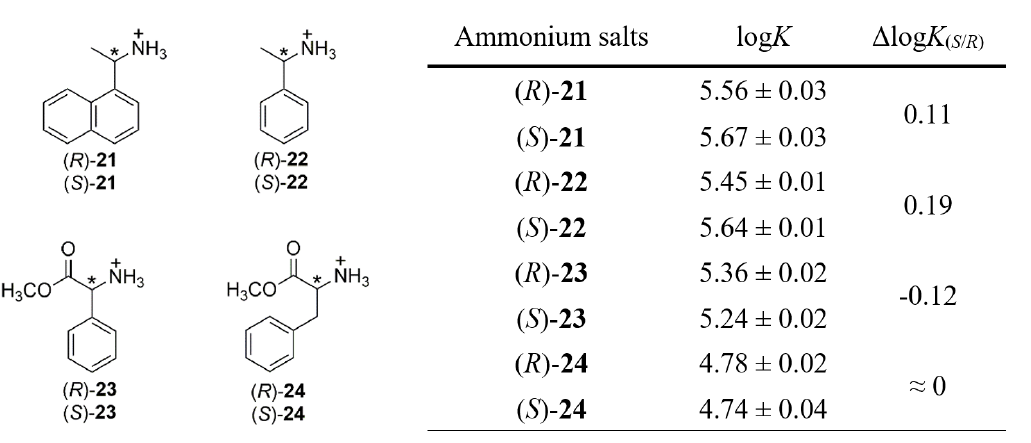
Figure 10. The logarithms of the stability constants (log K values) for the complexes of crown ether ( S , S )- 2 with the enantiomers of different primary ammonium salts and their diff erences (Δlog K ( S / R ) values), expressing the degree of enantiomeric recognition.